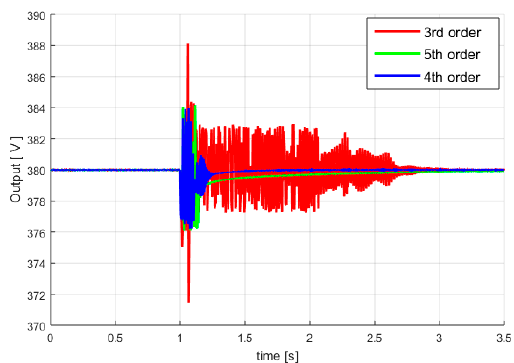
Figure 9. Terminal voltages—overlapped.